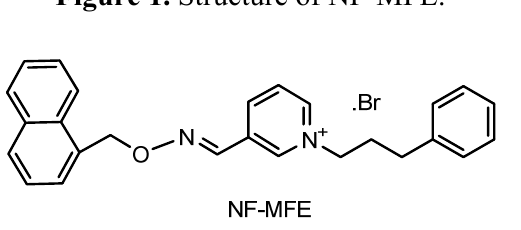
Figure 1. Structure of